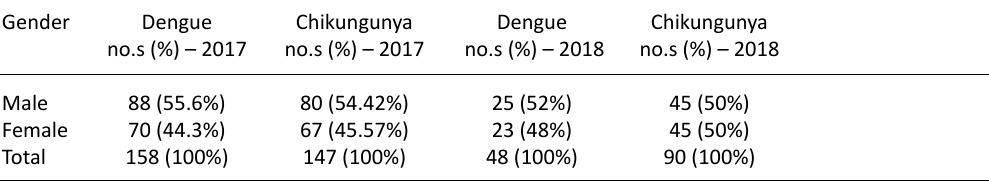
table 2. Gender distribution of Dengue and Chikungunya infection Gender